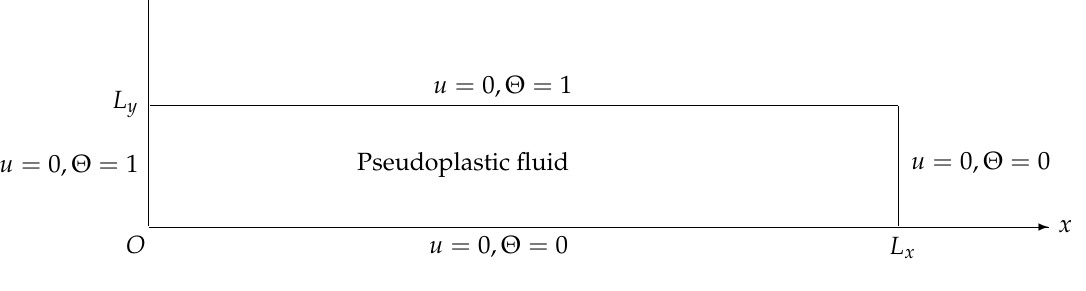
Figure 1. Schematic of the